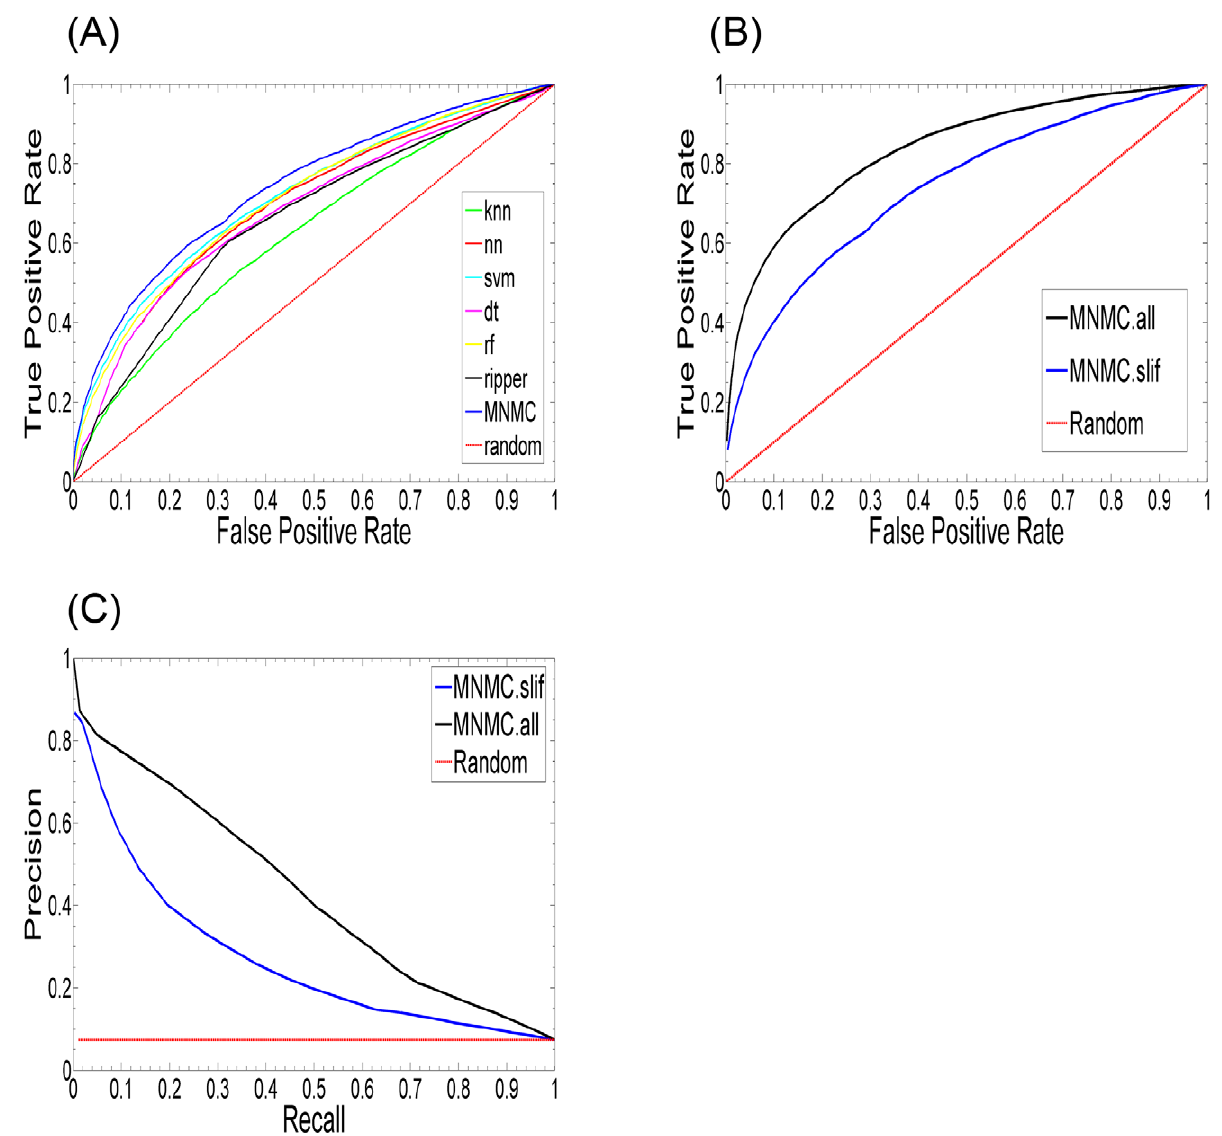
Figure 3. Classification on our SL dataset. (A) Receiver operating characteristic (ROC) curves of six individual classifiers and the ensemble (MNMC) using SL-independent features. (B) ROC curves for the ensemble classifier for our data set using all features (MNMC.all; AUC=0.837) and SL- independent features (MNMC.slif; AUC=0.741). (C) Precision-recall curves using all features (MNMC.all) and SL-independent features (MNMC.slif). The corresponding ROC and precision-recall curves for a random classifier are also